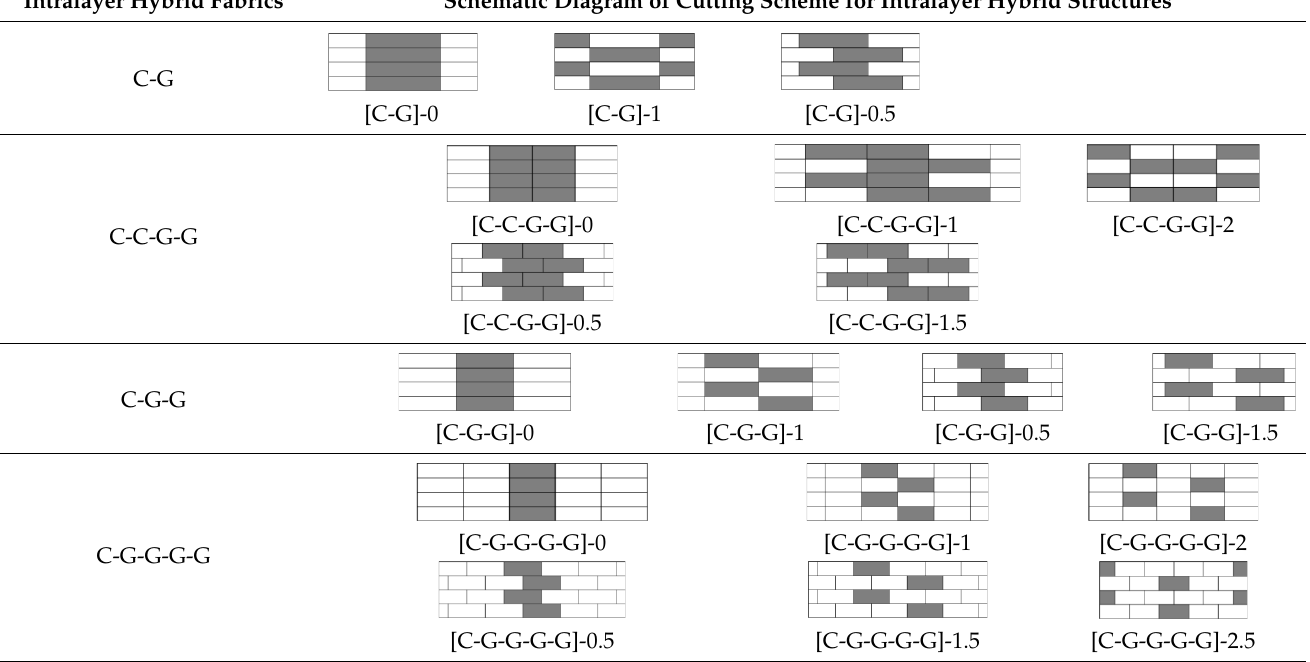
For C:G = 1:1, Figure 20 shows a comparison of the tensile properties of the intralayer hybrid structures [C-G] and [C-C-G-G]. We found that the tensile modulus and strength were maintained at the same level. As the dispersion degree increased, such as in [C-G]-1 and [C-C-G-G]-2, the tensile strength exhibited a decrease. Coatings 2023 , 13 , 774. https://doi.org/10.3390/coatings13040774